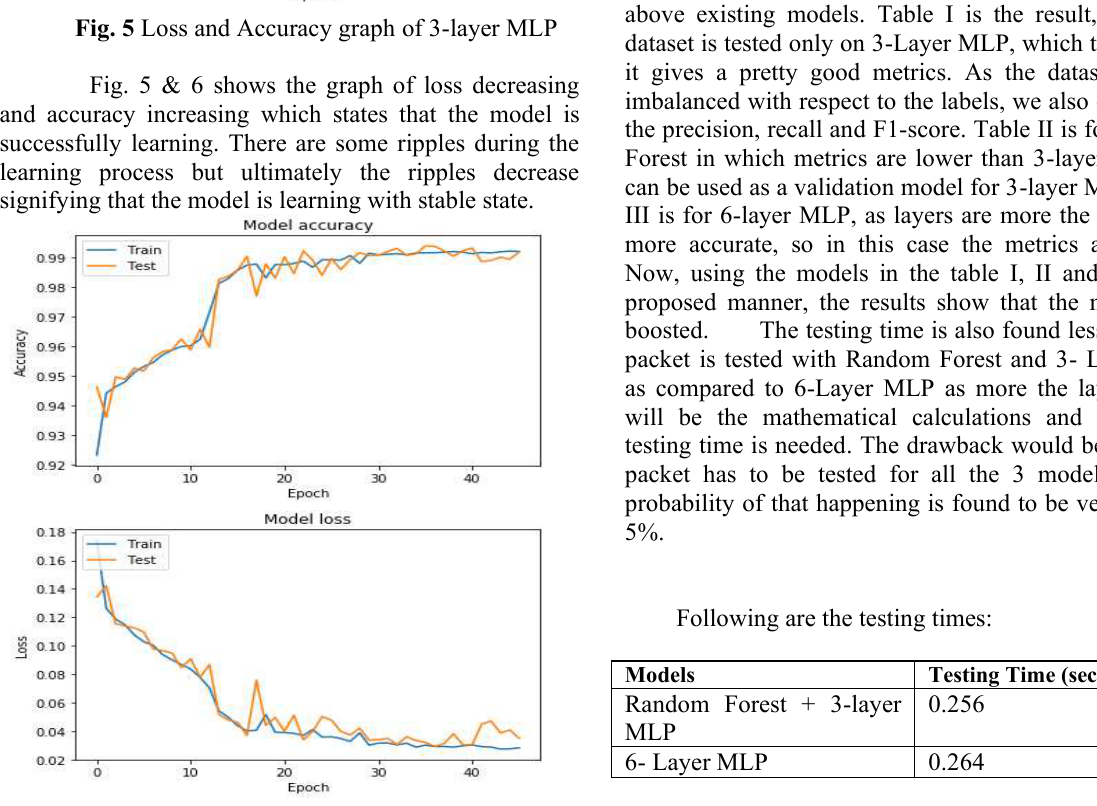
Fig. 6 6-Layer MLP Loss & Accuracy Graph